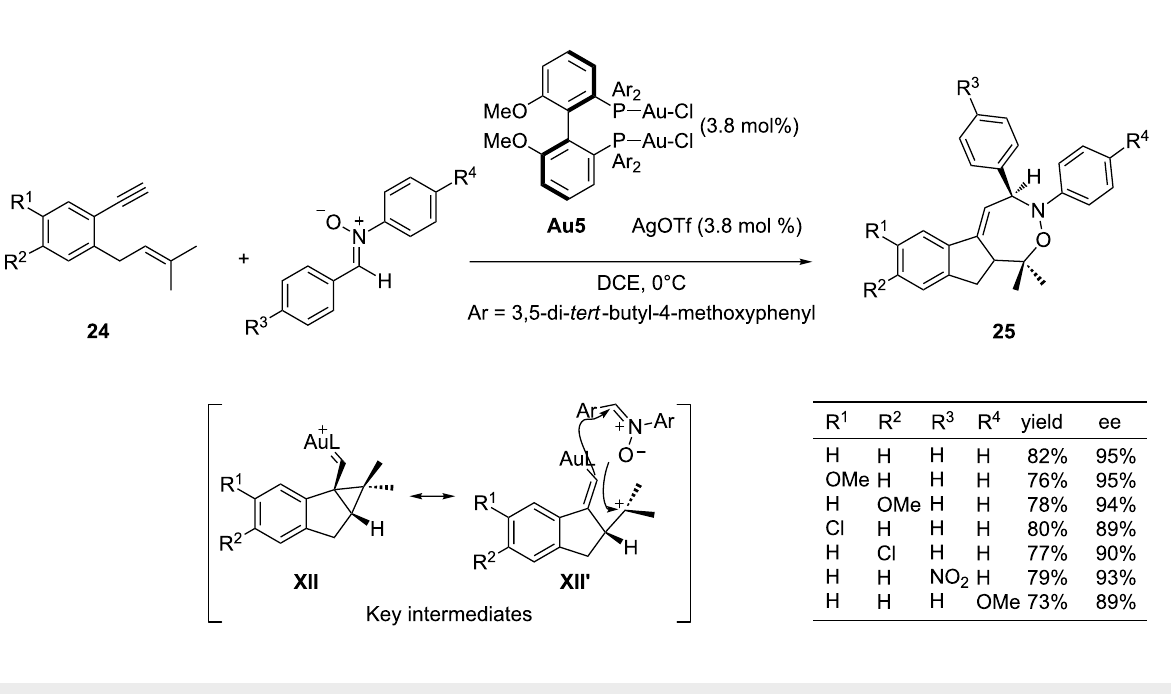
Scheme 16: Enantioselective formal [4 + 3] cycloadditions leading to 1,2-oxazepane